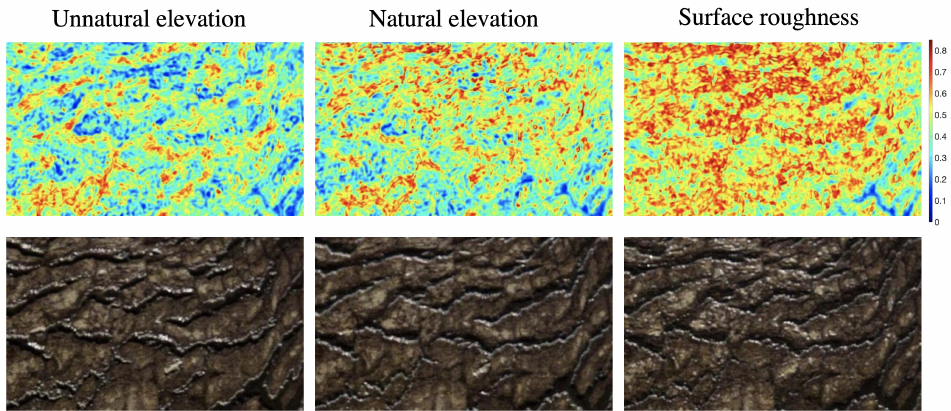
Figure 9. Example of more difference detection in print with surface roughness by iCID’s lightness structure map in the MS captures in the wood image. Zero means there is no difference while one means that there is more difference. The images were cropped for illustration purpose. The mean quality maps are given on top while registered 2.5D print captures of the MS at elevation angle = 30 ◦ and azimuth angle = − 20 ◦ are given on bottom.